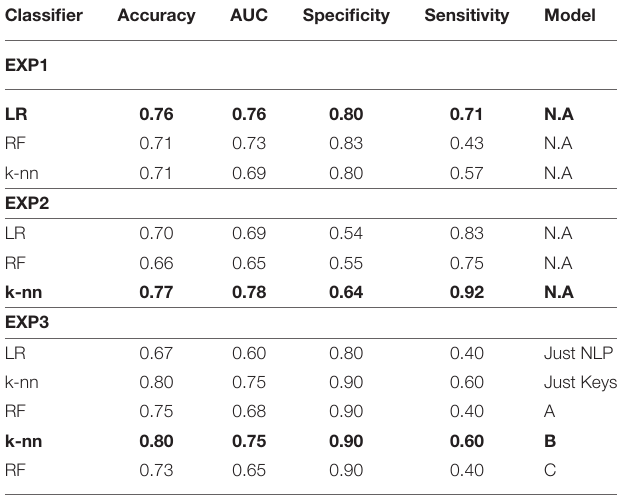
TABLE 4 | Cohorts (number of MCI:HC), optimal feature sets and models of the experiments EXP1, EXP2, EXP3. Cohort (MCI:HC) Feature set Model